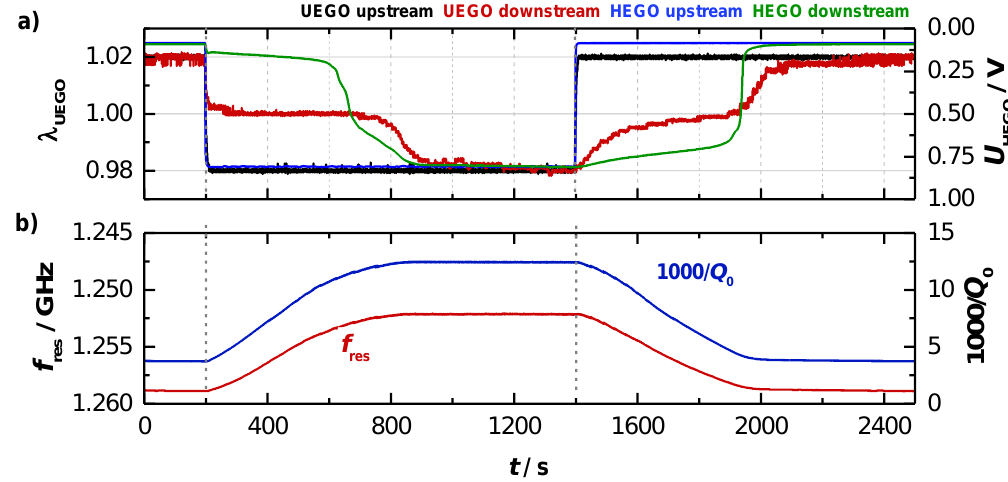
Figure 3. ( a ) Catalyst experiment of the three-way catalyst (TWC) at 400 °C with ( a ) the wideband and binary sensor signals and ( b ) the corresponding radio frequency signals f res and Q 0 − 1 of the TE 111 -Mode.